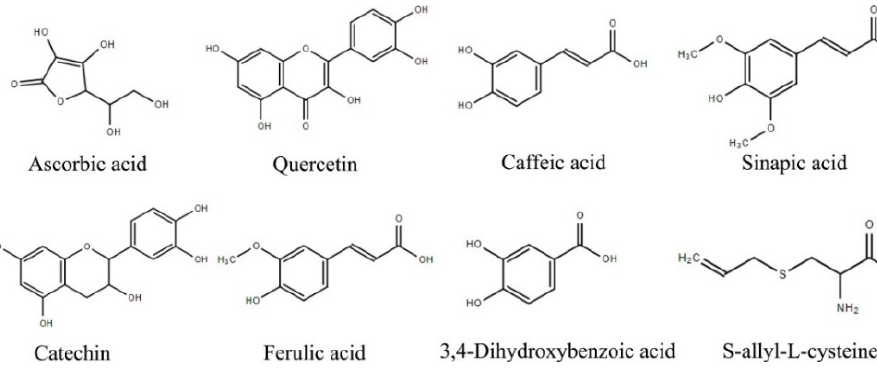
Figure 1. Chemical structure of 6 polyphenols and SAC. Further, in our study, ferulic acid and sinapic acid, whose phenolic hydroxyl ortho is methoxy, have stronger ABTS radical cation scavenging abilities than caffeic acid ( p < 0.05), suggesting the methoxy group of styrenic acid polyphenols contributes more to free radical scavenging than its phenolic hydroxyl group. Furthermore, the reducing power of caffeic acid was stronger than sinapic acid ( p < 0.05), which is not only related to the o-diphenol hydroxyl group, but also attributed to the existence of -CHCHCOO- side chain. The conjugated double bond on the side chain can also increase the charge distribution of the phenoxy radical through resonance and produce a strong electron pushing ability, so as to enhance the reduction ability of phenolic acid. In all, these results clearly indicated that the antioxidant effect (DPPH, ABTS, and reducing power) of six polyphenols were significantly higher than that of SAC ( p < 0.05). The principal reason for the lower antioxidant effect of SAC can be attributed to a lesser number of phenolic hydroxyl groups compared with that of the six polyphenols. Thus, studies on antioxidant interactions of the